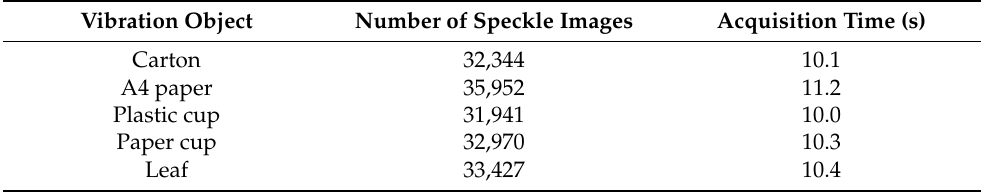
Table 4. The number of speckle images acquisitions for sinusoidal datasets.